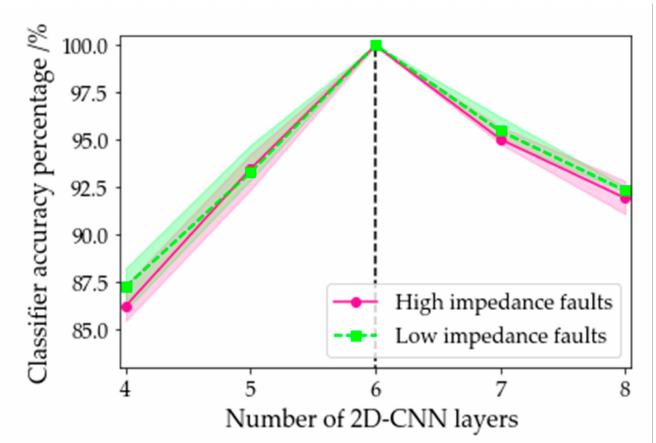
Figure 16. Test results when the number of 2D-CNN layers changes.